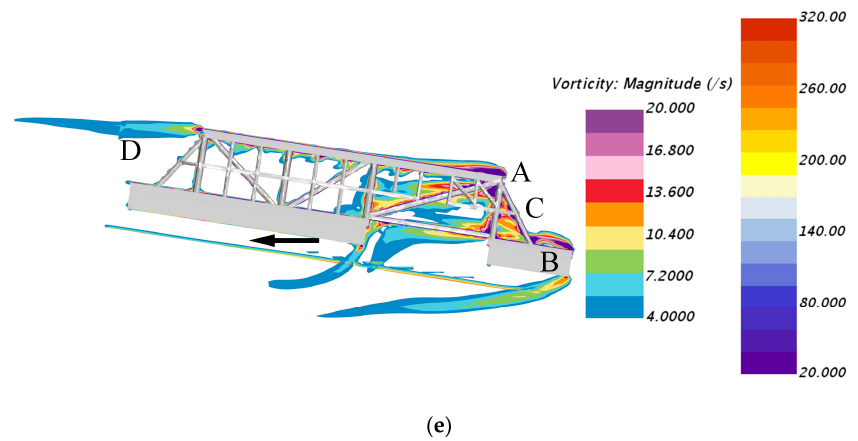
Figure 14. Cross-sections of flow field colored according to vorticity magnitude for Y-direction towing: ( a ) Vortex field in Case 6, α Y , CFD = 0.974 ◦ , ( b ) Vortex field in Case 7, α Y , CFD = 2.018 ◦ , ( c ) Vortex field in Case 8, α Y , CFD = 3.838 ◦ , ( d ) Vortex field in Case 9, α Y , CFD = 6.218 ◦ , ( e ) Vortex field in Case 10, α = 8.770 ◦ . Y , CFD